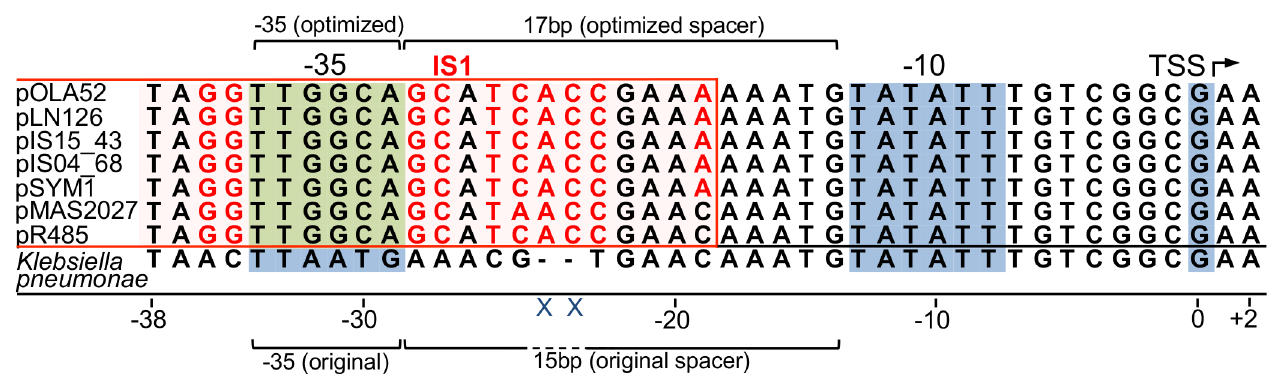
Fig 2. Nucleotide sequence alignment of mrkA promoters of plasmids from non- Klebsiella hosts (P mrkA [P] ) and K . pneumoniae (P mrkA [Kp] ). Residues that do not align with P mrkA [Kp] are indicated in red, which are all associated with IS1 elements (red lining). Blue background highlights conserved P mrkA [Kp] components and green background denotes the unique -35 box found in P mrkA [P] . TSS: transcriptional start site. P mrkA [P] is predicted to be a stronger promoter than P mrkA [Kp] due to an optimized -35 box and a 2 bp longer spacer region between the -10 box and -35